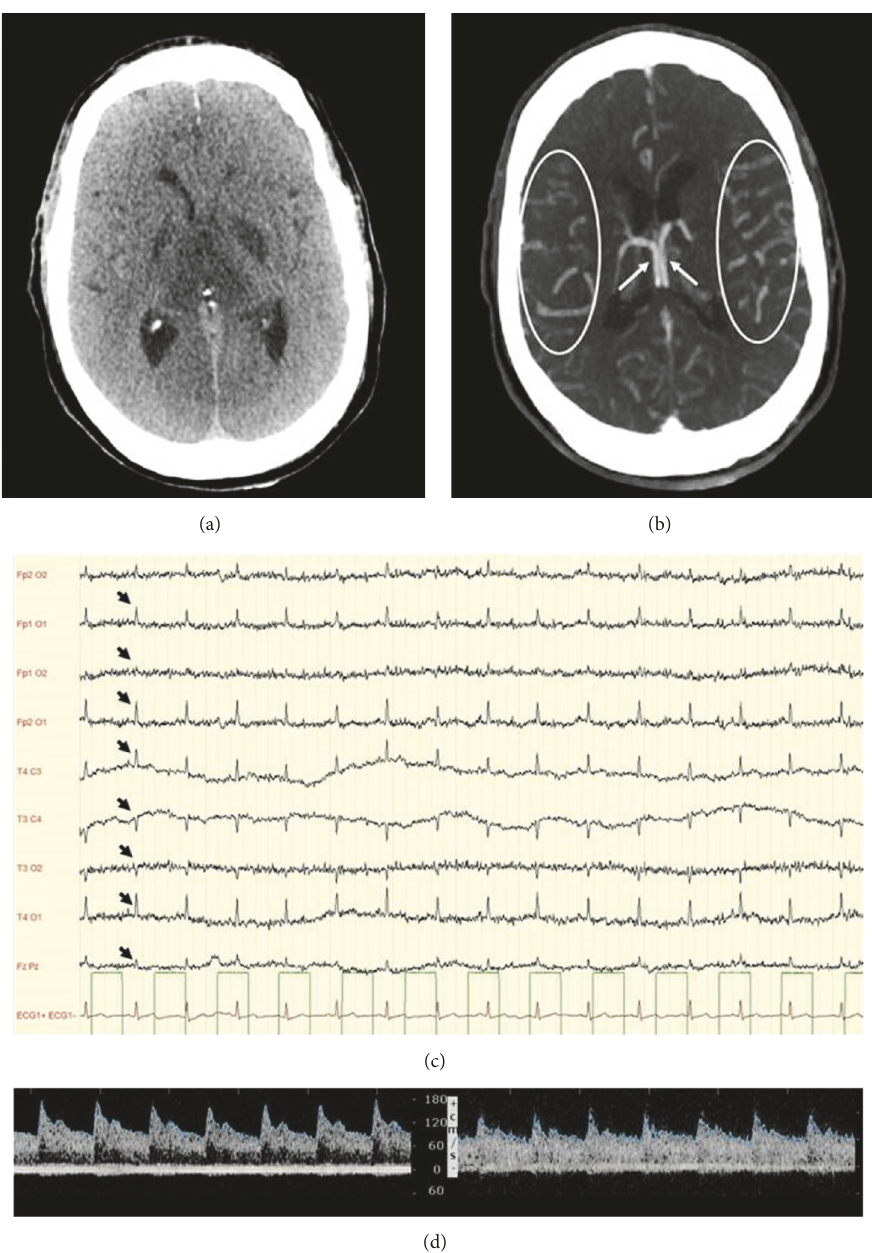
Figure 1: (a) Cerebral CT scan at H76. Brain tissue shows a loss of differentiation between white matter and gray matter. Lateral ventricles are preserved and Sylvian fissures are visible. (b) Cerebral CT angiography. Bilateral opacification of the internal cerebral veins (arrows) and of the cortical (M4) segment of middle cerebral arteries (circled). The four nonopacification criteria used to confirm brain death are absent. (c) Electroencephalogram. Absence of brain electrical activity, including stimulation, on all derivations confirmed on two 30-minute EEGs done 4 hours apart confirmed brain death. Cardiac electric activity is seen on the EEG (black arrow) synchronized with the actual electrocardiogram (red line). (d) Transcranial Doppler of the right and left middle cerebral arteries. The cerebral blood flow has a normal aspect. There are no signs of intracranial hypertension as diastolic velocities are over 40 cm/s and the Pulsatility Index is above